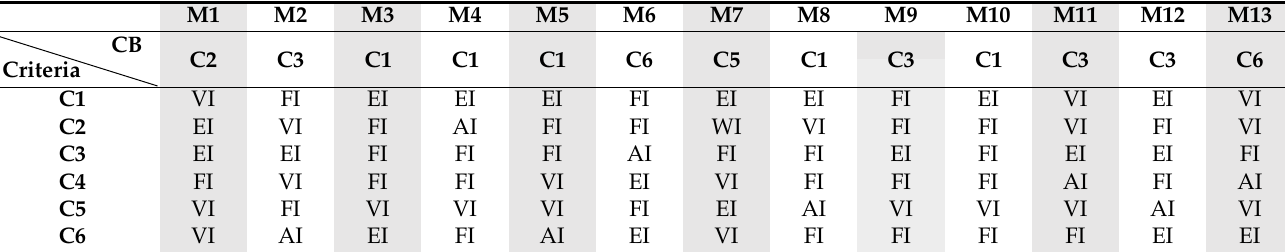
Table 4. Comparison of best criterion to the others.